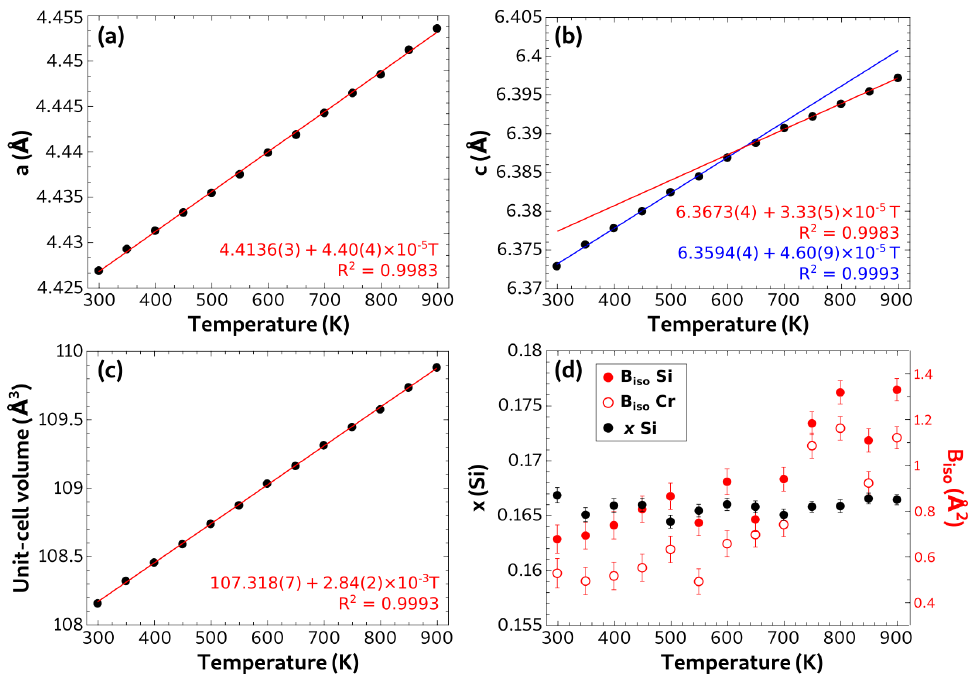
Figure 3. Thermal evolution of the lattice parameters ( a ) a and ( b ) c , ( c ) the unit cell volume and ( d ) the positional parameter x in black and the global isotropic atomic displacement parameters B iso in red.